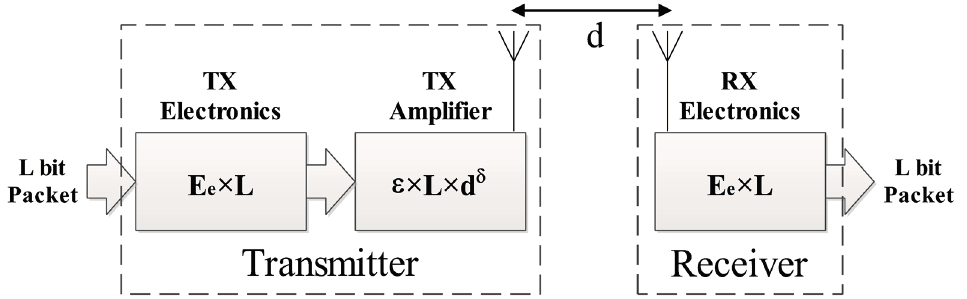
Figure 1. The transmission and receiving energy consumption